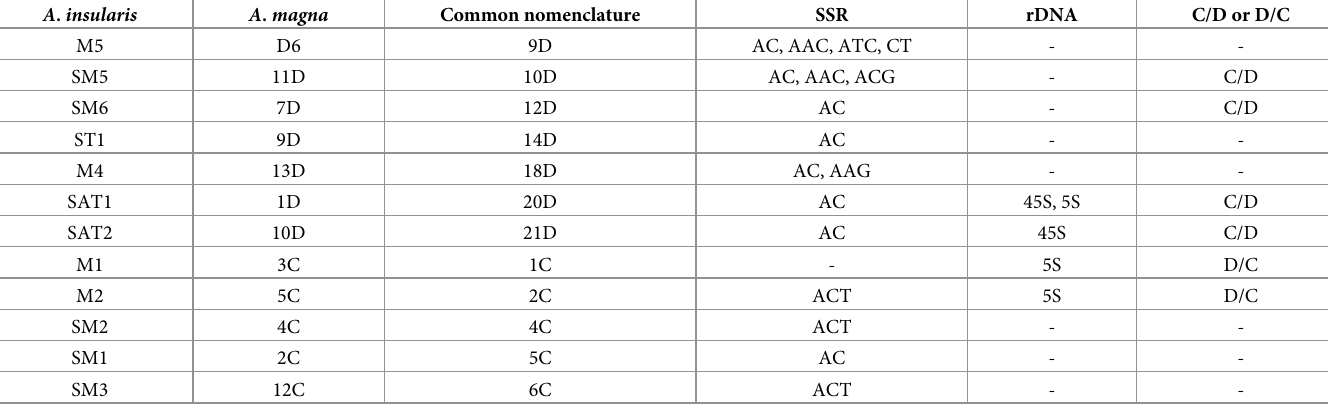
Table 2. Common nomenclature for A . insularis and A . magna for D genome chromosomes and several C genome chromosomes regarding to chromosomes of the hexaploid species, based on SSR hybridization patterns shared for at least two species, 45S and 5S loci, and intergenomic translocations (C/D or